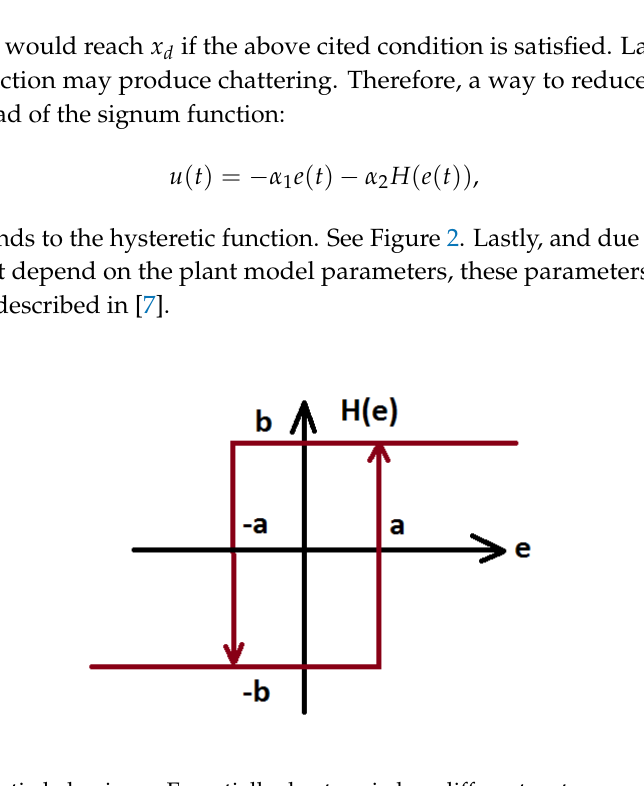
Figure 2. Hysteretic behaviour. Essentially, hysteresis has different outcomes dependent on the direction of the input signal. In addition, this behaviour has memory due to the fact that the output at any instance of time may depend on the whole history of the input